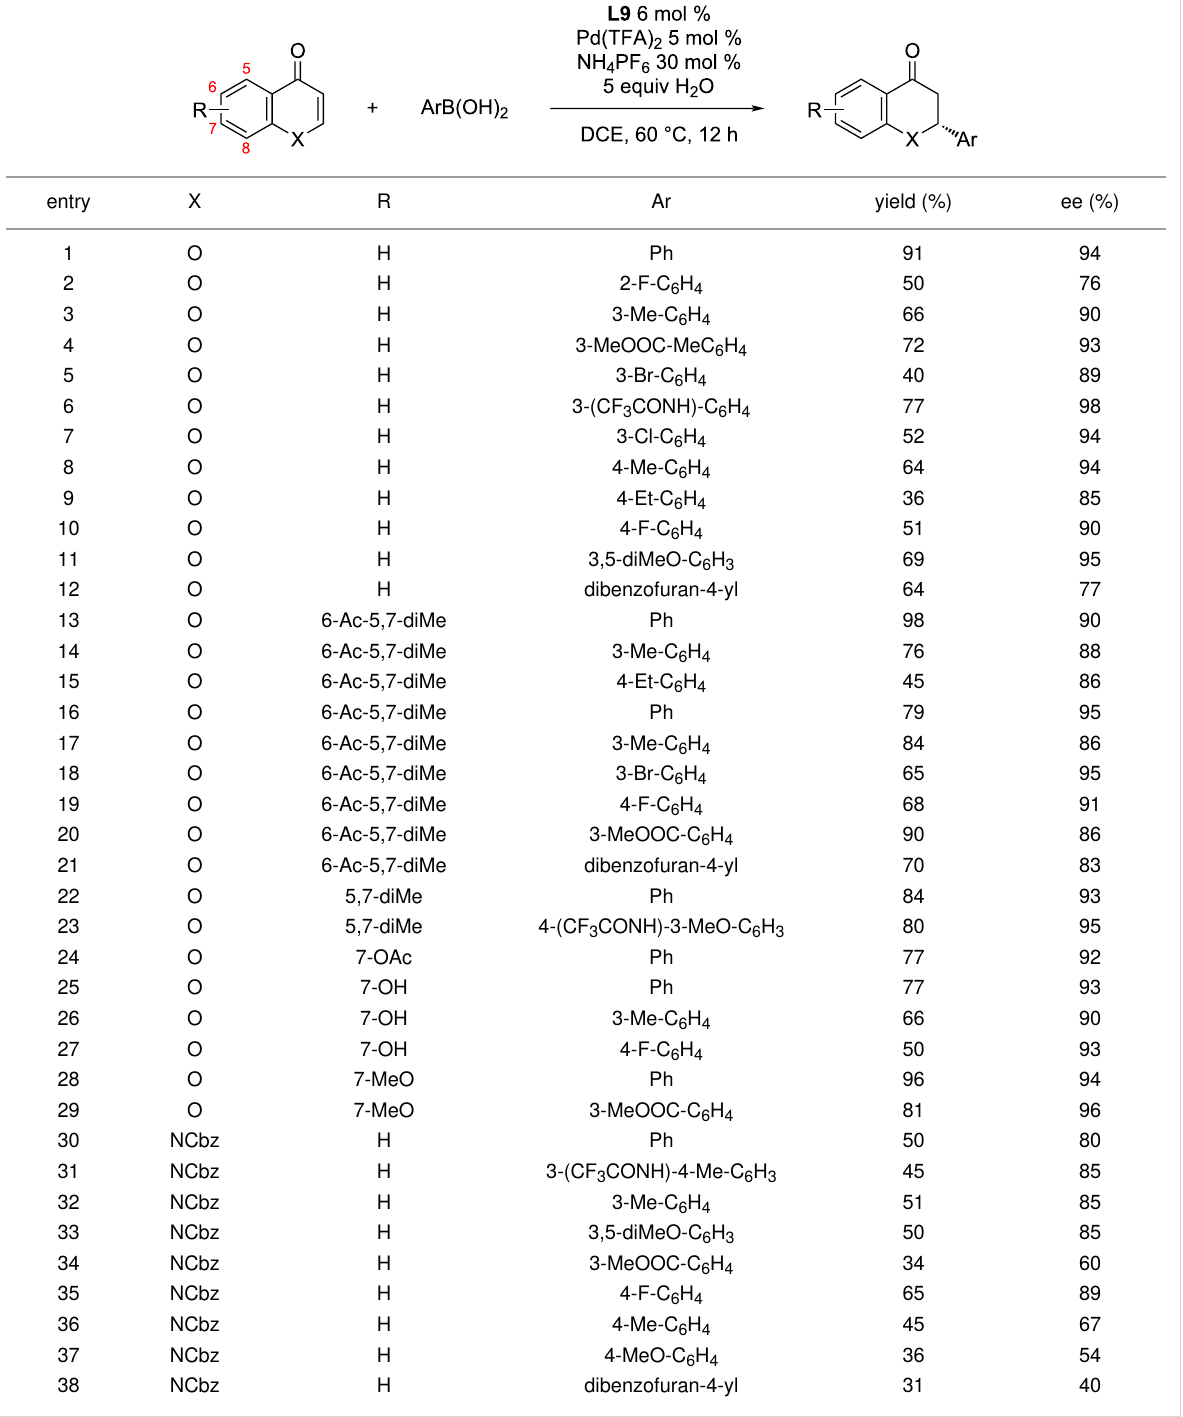
Table 23: Addition reactions of arylboronic acids to substituted chromones and N -Cbz-4-quinolones catalysed by L9 /Pd(TFA) 2